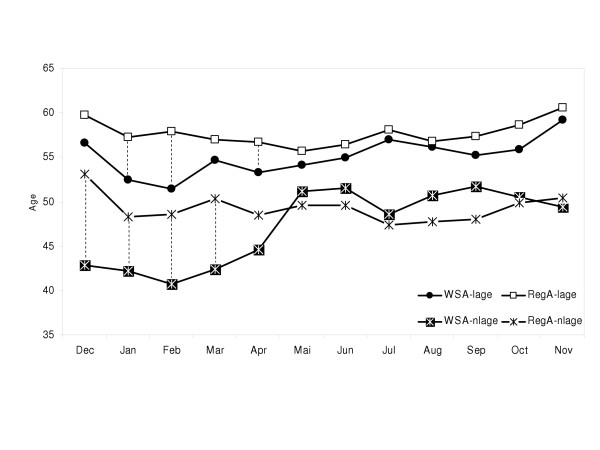
Monthly average age of admitted nonlocal and local residents in WSA and RegA HSAo. Monthly average age of nl-res and l-res in winter sport (WSA) and regular (RegA) HSAo; 2000–2002. nlage = nl-res age, lage = l-res age, ------ = significant difference.